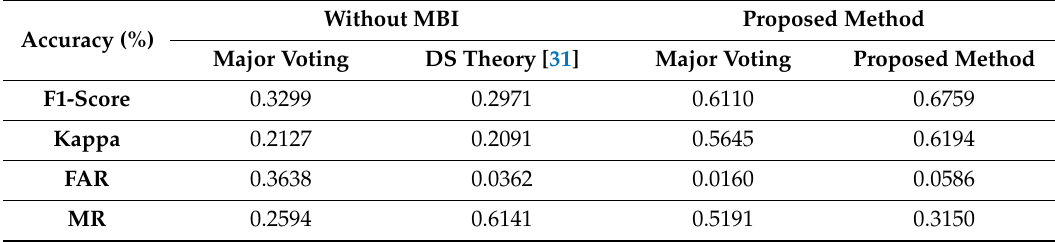
Table 3. Accuracy assessment of change detection for first subset results generated without using MBI and by the proposed